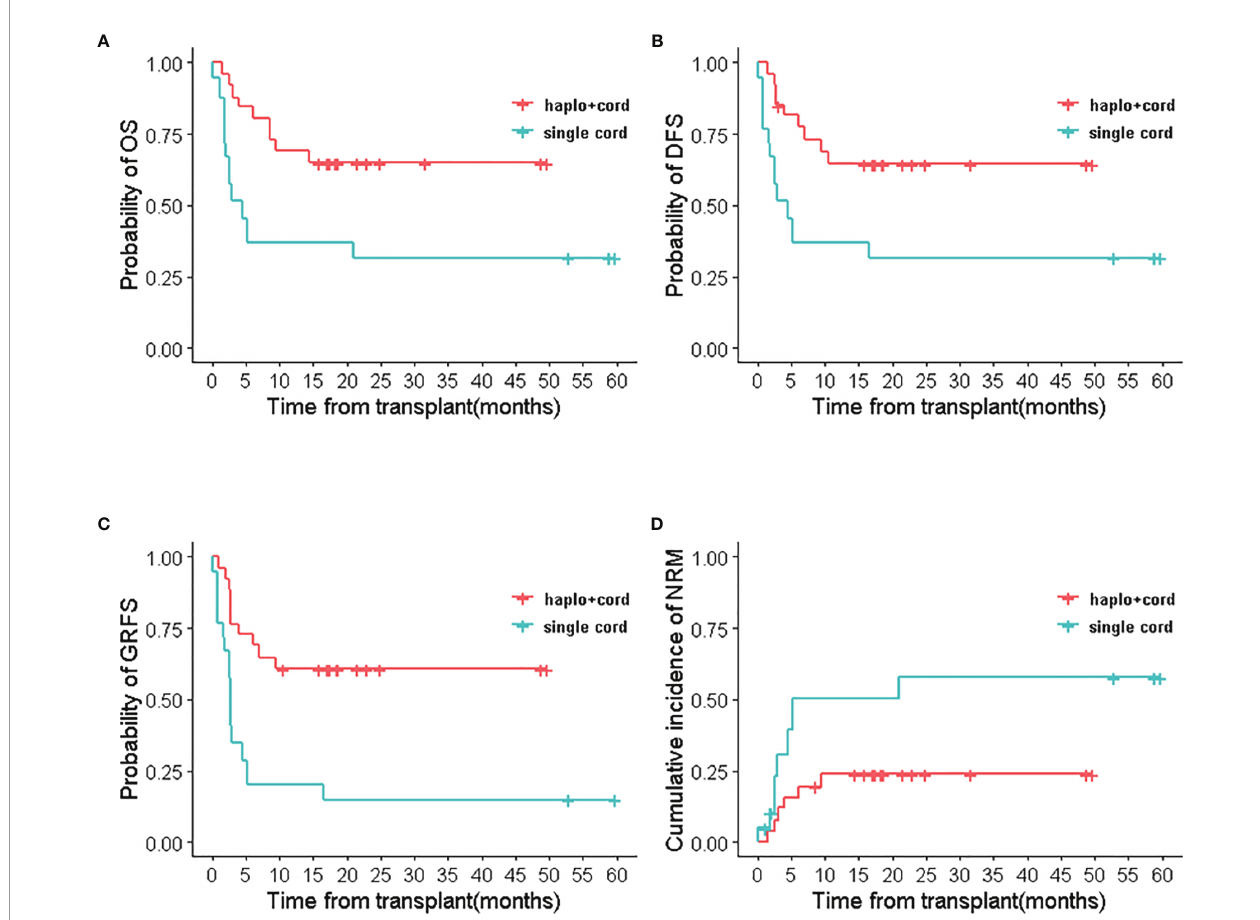
FIGURE 4 | The relapse/refractory patients ’ outcomes of haplo-cord HSCT and single UCB-HSCT group after IPTW. (A) OS, (B) DFS, (C) GRFS, (D) NRM.